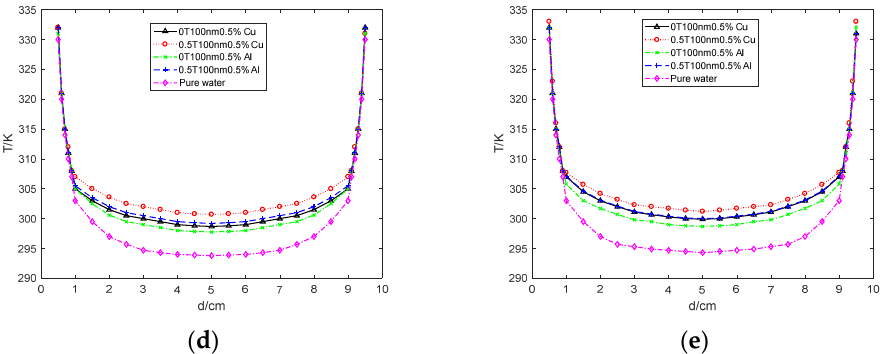
Figure 4. The temperature distributions of Cu-H 2 O and Al-H 2 O nanofluids flow along the diameter on faces 2 ( a ), 3 ( b ), 4 ( c ), 5 ( d ), and 6 ( e ), respectively. The magnetic fields were applied along the X direction.